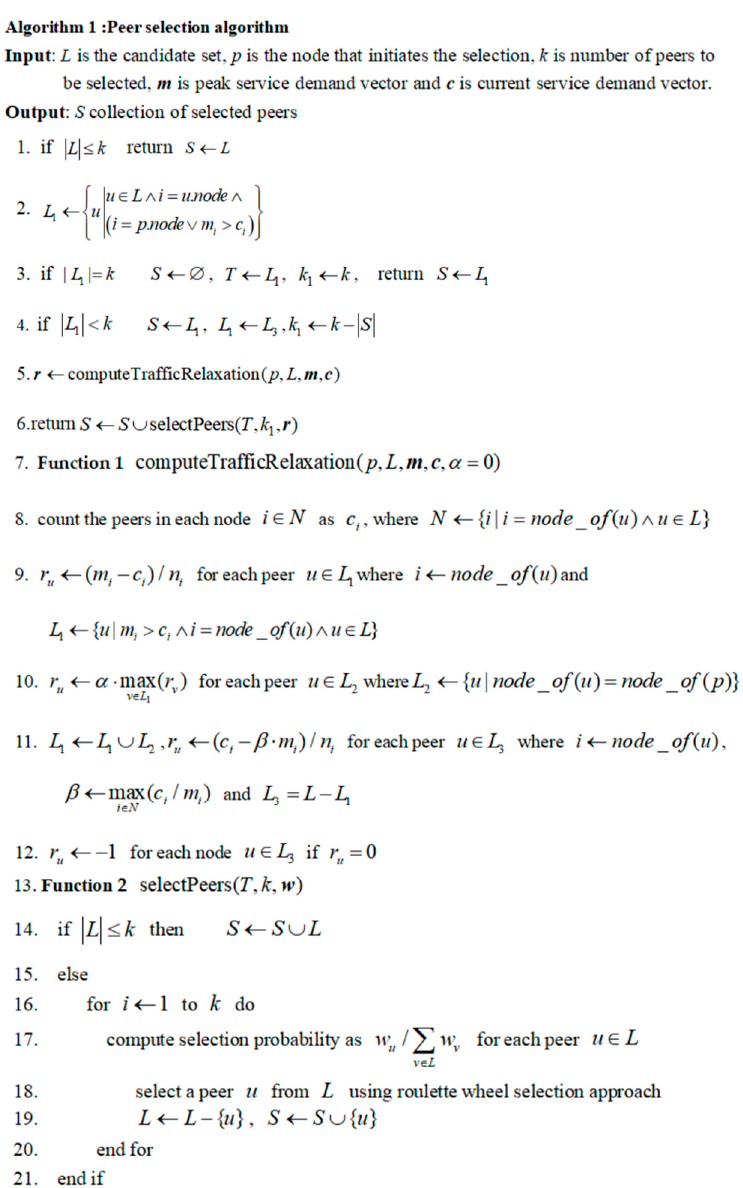
Figure 2. Pseudo code of the peer selection algorithm.